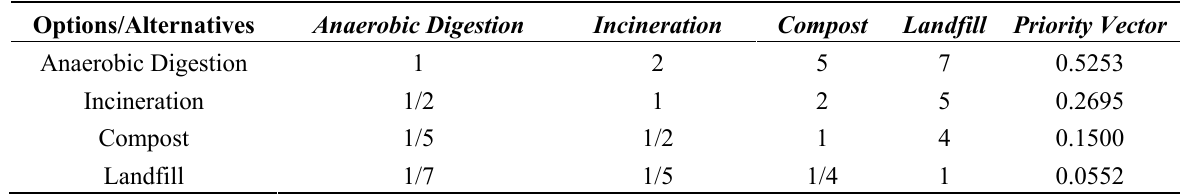
Table 6. Pairwise comparison matrix for the options with regards to technical criteria.